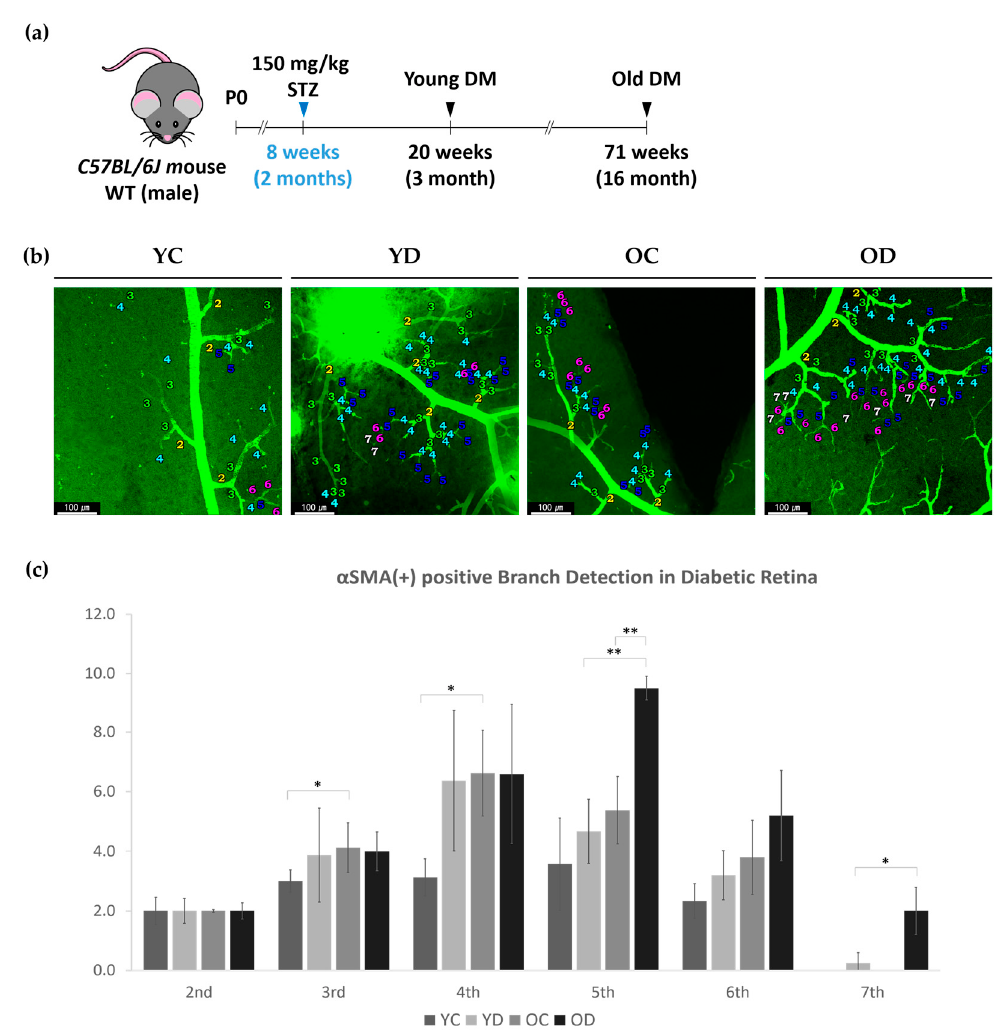
Figure 2. α SMA-positive branch order detection in diabetic retina. ( a ) Diagram depicting the experiment schedule for induction of streptozotocin-induced diabetes at 8 weeks old C57Bl / 6 male mice. ( b ) Representative images show the branches including the highest-ordered branch detected in each condition; Young Control (YC), Young Diabetes (YD), Old Control (OC), and Old Diabetes (OD). Note that both diabetic groups were able to detect up to 7th order. ( c ) The graph indicates the counts of average branch orders detected per two second ordered branches. Error bars indicate SD. (2-way ANOVA; N = 16 per group, * p < 0.05, ** p < 0.01).